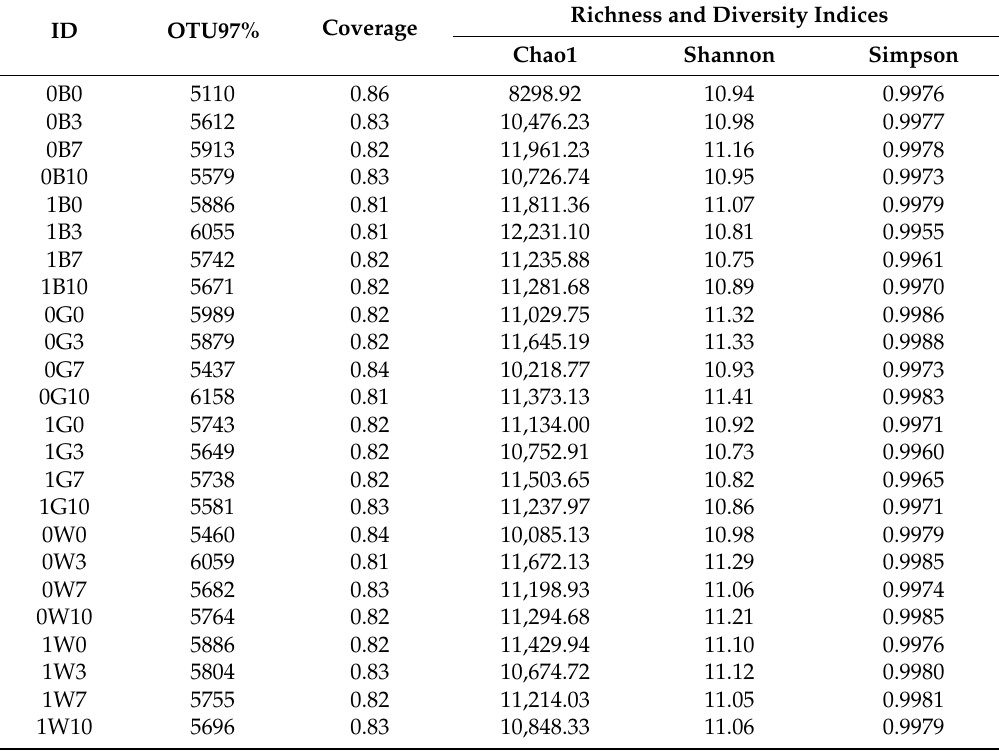
Table 3. Diversity indices calculated based on a cutoff of 97% similarity of 16S rRNA sequences of 18,670 reads per sample.